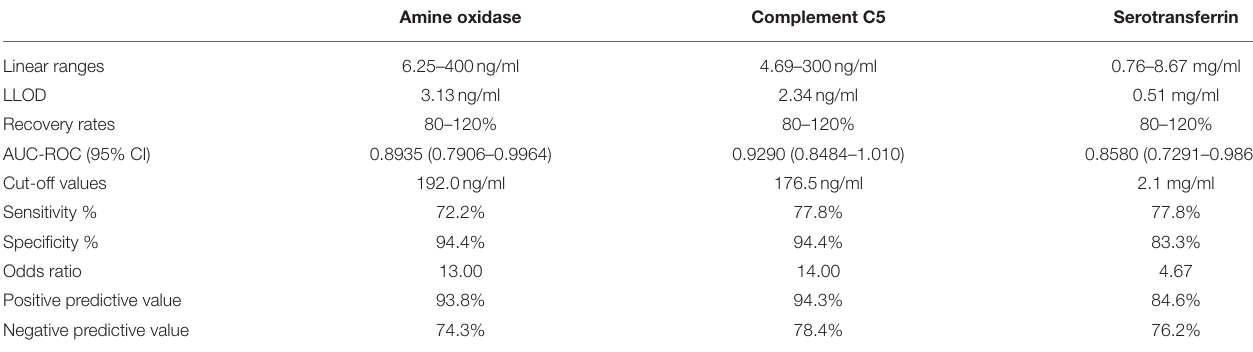
TABLE 2 | Performance parameters of each in-house